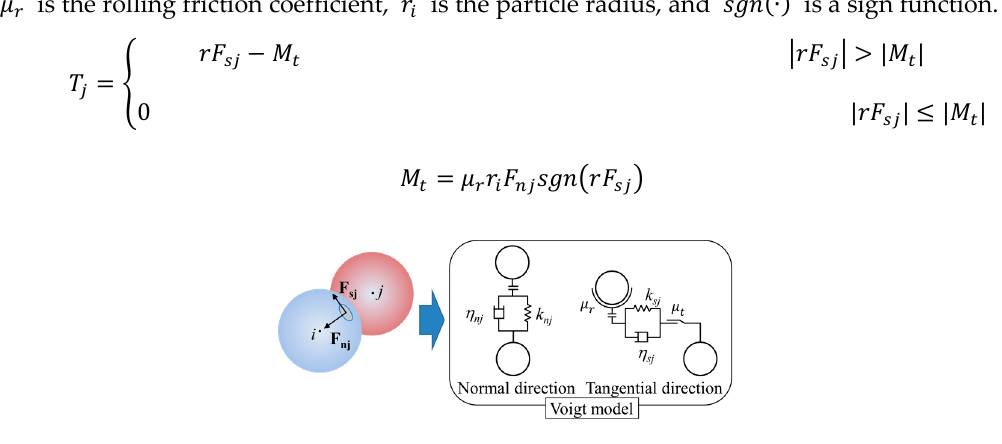
Figure 3. Model of snow with particle elements.